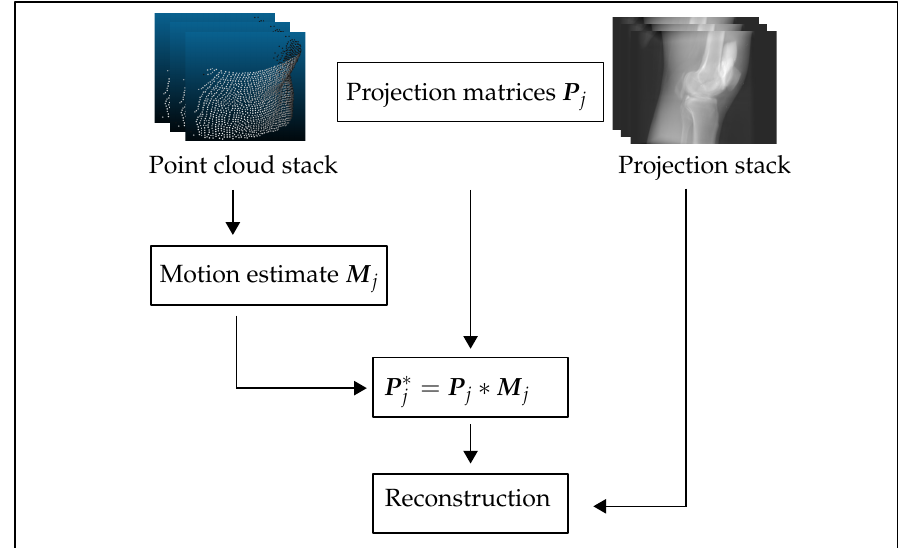
Figure 3. Method work flow: point clouds were used to estimate patient motion, which is then used for